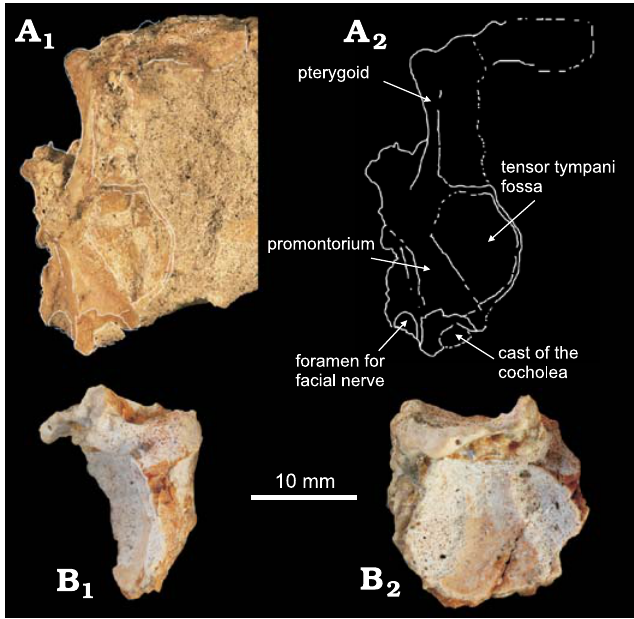
Fig. 10. Fragmentary pterygoid and middle ear cavity of multituberculate mammal Sphenopsalis nobilis Matthew, Granger, and Simpson, 1928 from the upper Paleocene Nomogen beds at the Erden (Urtyn) Obo locality, Inner Mongolia, China. A . IVPP V19025, middle ear with part of the promonto- rium in ventral view; photograph (A 1 ), explanatory drawing (A 2 ). B . IVPP V19029, possible bony shell of the inflated vestibule in lateral (B 1 ) and inside (B 2 ) views. The anterior end of each element is toward